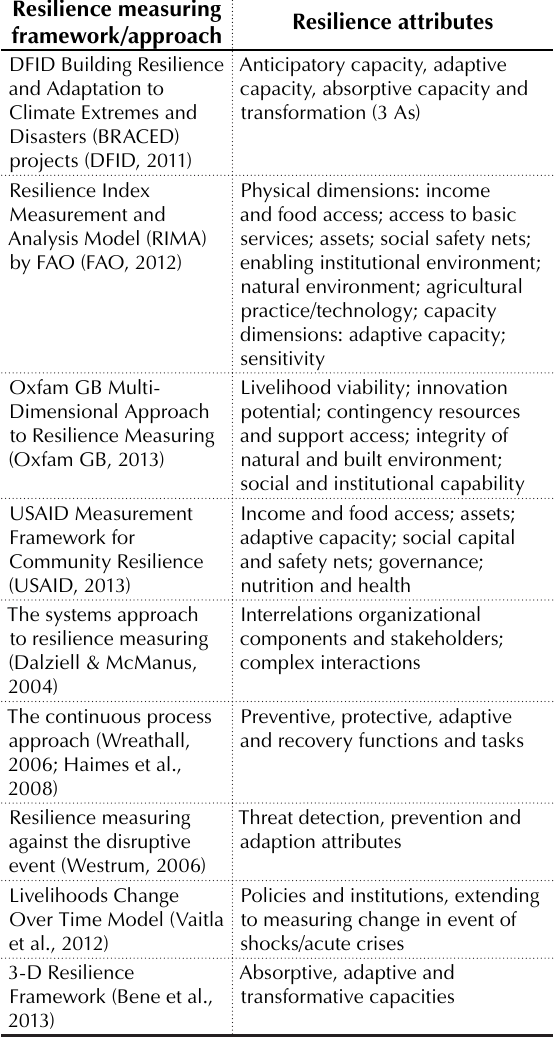
Table 1. Existing frameworks/approaches to measuring